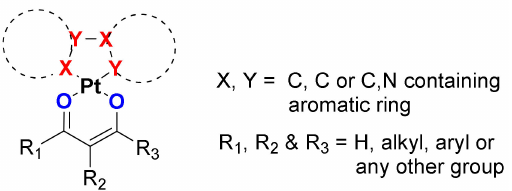
Figure 1. A general chemical structure of cyclometalated Pt(II) β -diketonate complexes covered in this review. Two aromatic rings (dotted lines) are joined through C-C or C-N